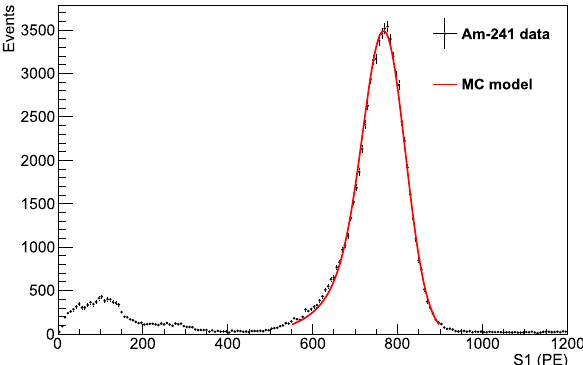
Fig. 7 Scintillation top-bottom asymmetry for full-energy 241 Am events taken in single-phase mode at null field